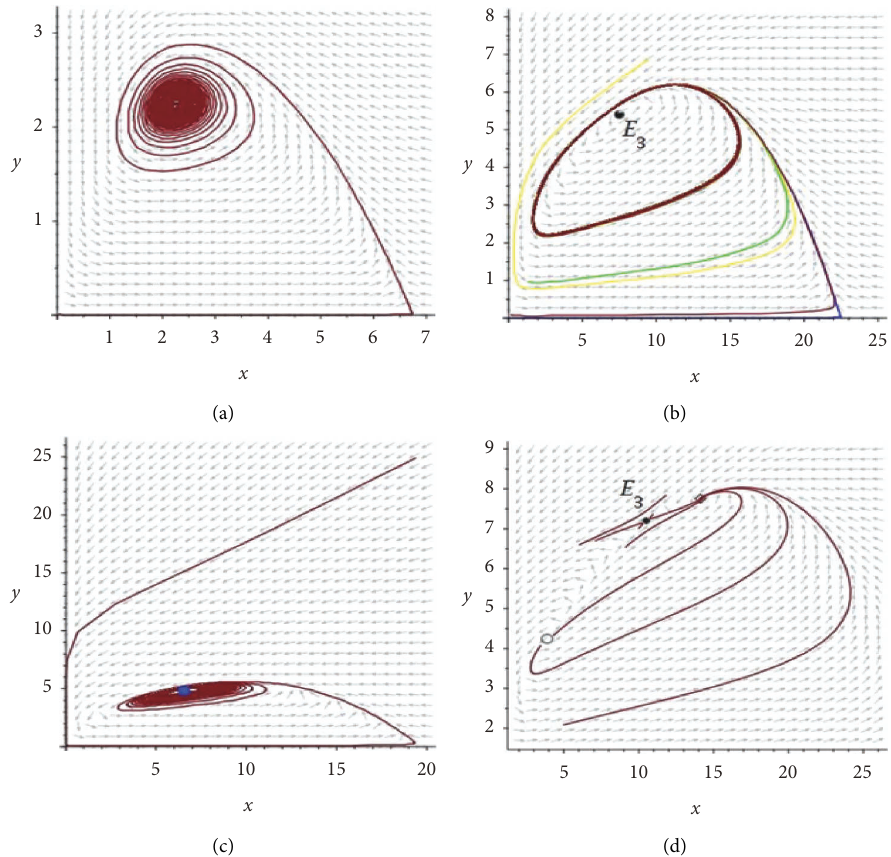
Figure 2: Phase diagrams around E in the case (C1) with ( λ � ( 1/2 )) : (a) A stable multiple focus with multiplicity one with μ � 3; (b) An 3 unstable multiple focus with multiplicity one with μ � 10; (c) A stable weak focus of order 2 with μ � μ